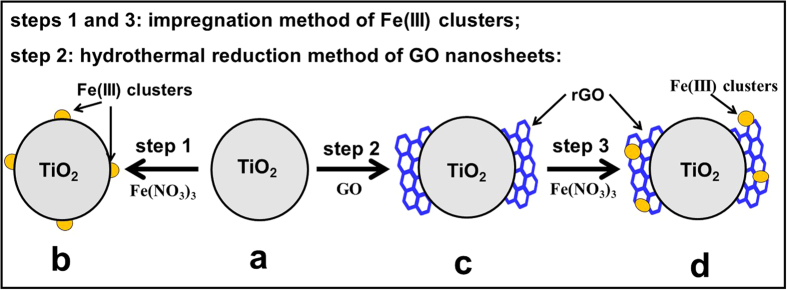
Schematic diagram illustrating the controllable preparation of the samples:(a) TiO2; (b) Fe(III)/TiO2; (c) rGO-TiO2; (d) Fe(III)/rGO-TiO2.